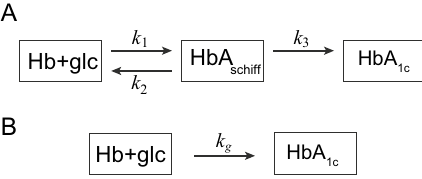
Figure 1. Hemoglobin glycation. ( A ) HbA1c is produced from Schiff base by amadori rearrangement. ( B ) Simplified two compartment model. HbA schiff is aldimine complex (intermediate product). k 1 , k 2 , k 3 , k g are kinetic constants.